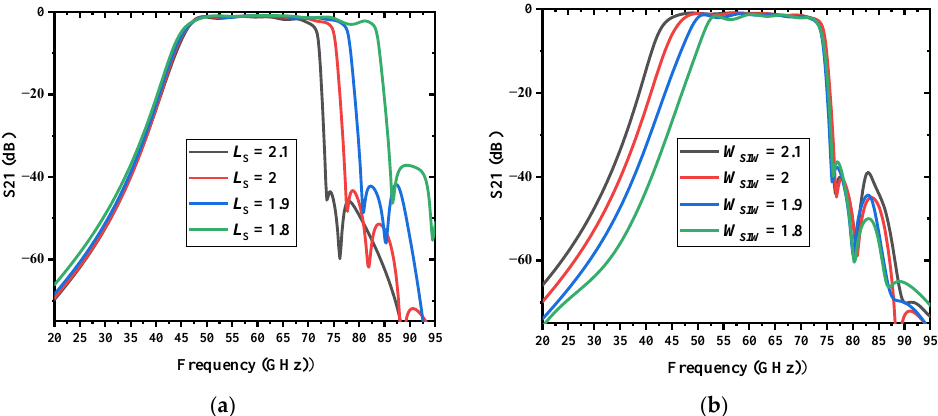
Figure 5. Simulated results of the proposed bandpass filter with different ( a ) SSPPs length L S . ( b ) SIW